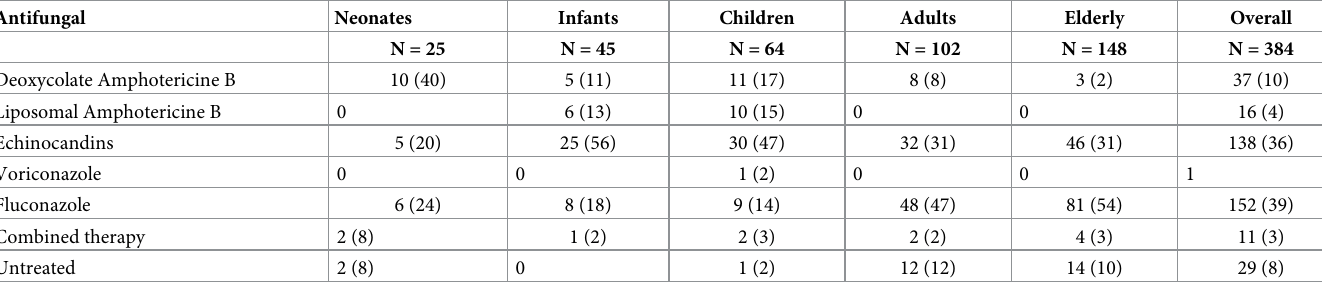
Table 5. Primary antifungal therapy of 384 patients with candidemia, by age